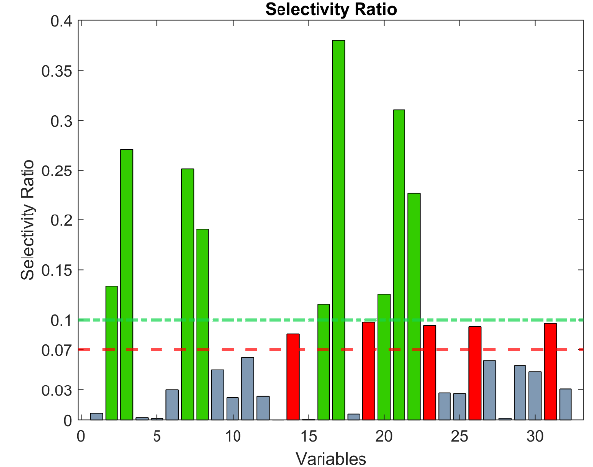
Figure 3. Selectivity ratio of the 32 selected features. The variables above the threshold of 0.1 are reported in green, and the ones between the thresholds 0.07–0.1 are reported in red.